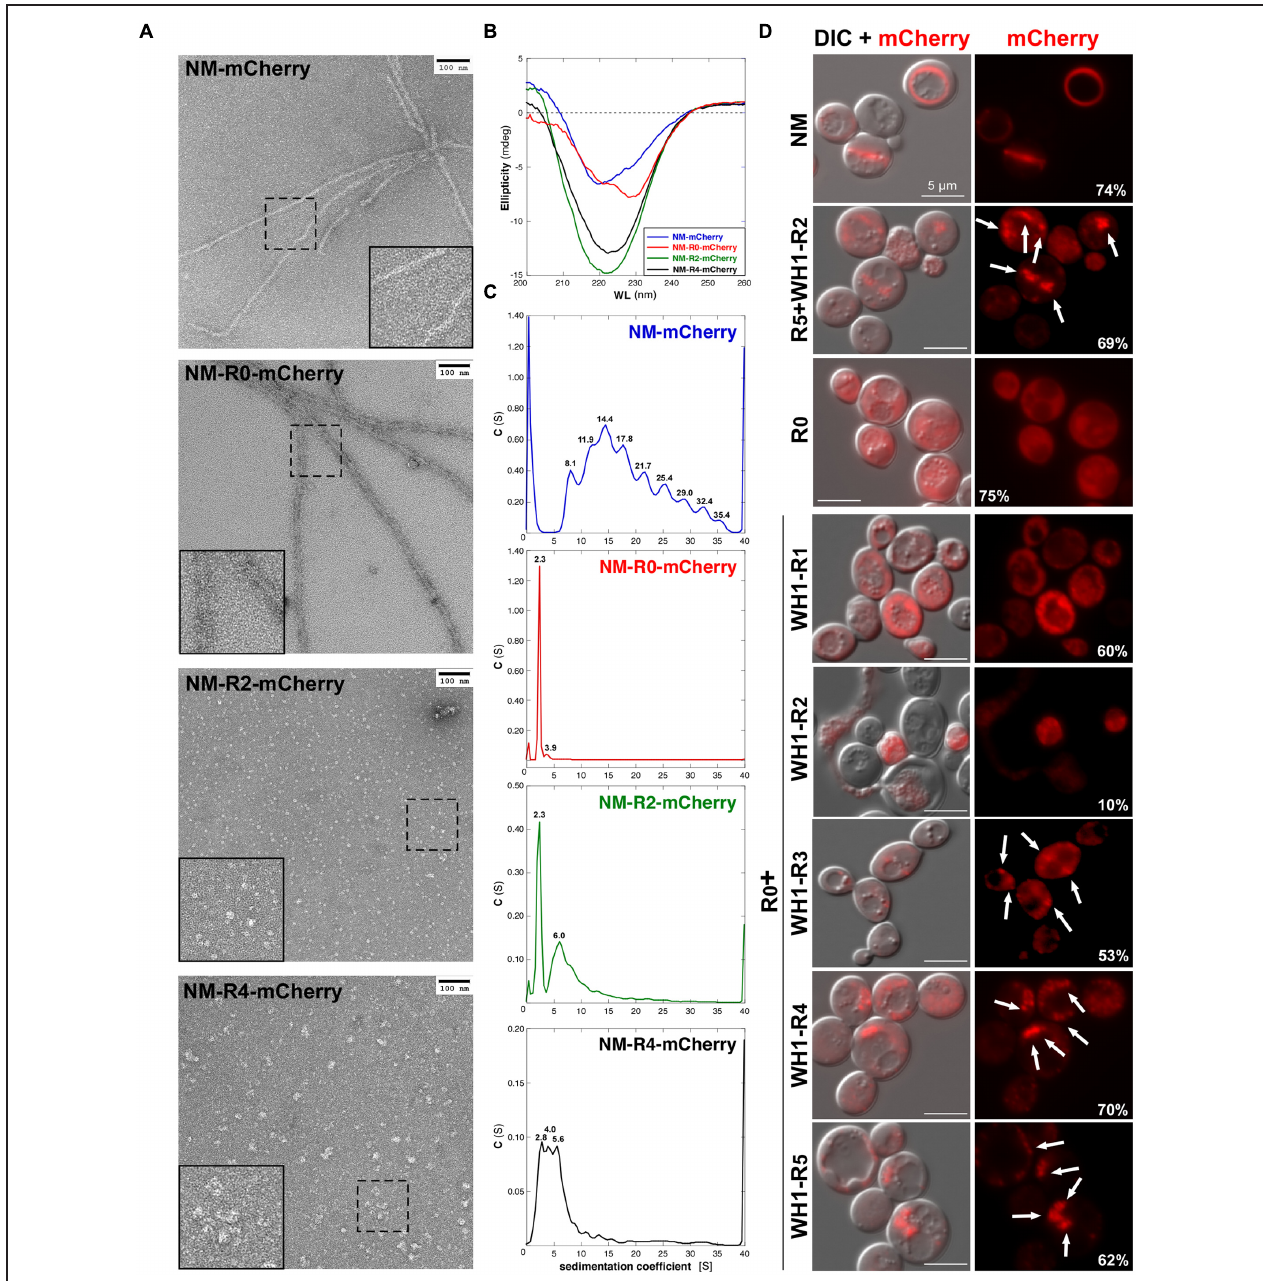
FIGURE 5 | Chimeric NM domains from [ REP-PSI + ] fused to the mCherry reporter form oligomeric assemblies. (A) Purified His 6 -tagged NM-mCherry fusions (15 μ M) were assembled in vitro and visualized by transmission electron microscopy. Insets are twofold magnifications of areas within dashed boxes. RepA-WH1 repeats drive the assembly of the NM-mCherry proteins into particles whose sizes increase with the number or repeats. (B) Circular dicroism (CD) spectra of the purified, preassembled NM-mCherry proteins (15 μ M) showed an increase in β -sheet structure (broad minima at ≈ 220 nm) for the R0 + WH1-R2/4 chimeras. (C) Sedimentation velocity experiments were performed in an analytical ultracentrifuge with the same purified NM-mCherry proteins (10 μ M) studied in (A,B) . The analyses indicate poly-dispersed aggregation for the chimeras (i.e., multi-peaked profiles), with a direct correlation between the number of